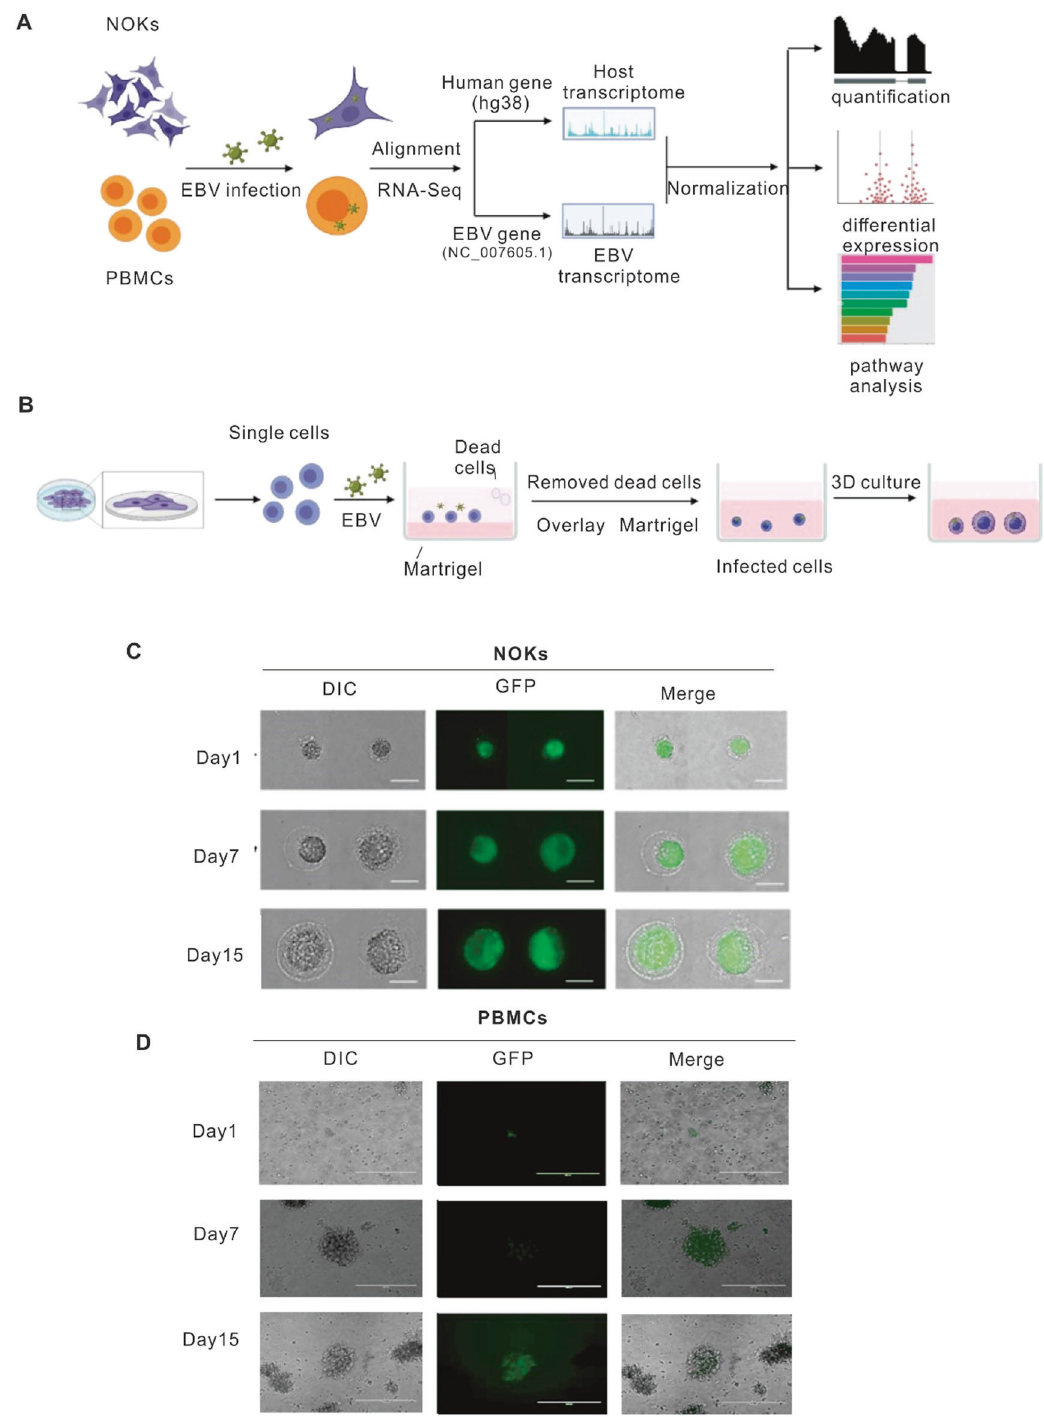
Fig. 1 Establishment of EBV-infected NOK-derived 3D culture system and PBMC. Generation and con fi rmation of EBV infection. To establish 3D NOKs cultures, Matrigel was poured onto 12-well culture plates to a depth of approximately 0.2 mm, followed by polymerization for 30 min at 37 °C. The mixture of BAC GFP-EBV and single-cell suspension of NOKs were placed on the surface of the Matrigel matrix and incubated at 37 °C overnight. The next day dead cells were removed by aspiration, and a Matrigel layer was overlaid to cover the cells attached to Matrigel at the bottom. After the Matrigel solidi fi ed, the culture medium was added and changed every 2 days. After 2 days the NOKs cells invade the matrix to form multicellular spheroids. PBMCs were infected with BAC GFP-EBV, then we check the GFP after 7 days and 15 days. A Schematic illustration of study design. B The fl owchart of key procedures to establish BAC GFP-EBV infected NOKs-derived 3D culture system. C Representative image of BAC-GFP-EBV infection-mediated GFP expression in NOKs 3D culture at different days (ampli fi cation: 400×). D Representative image of BAC-GFP-EBV infection-mediated GFP expression in PBMCs culture at different days (ampli fi cation: 200×).